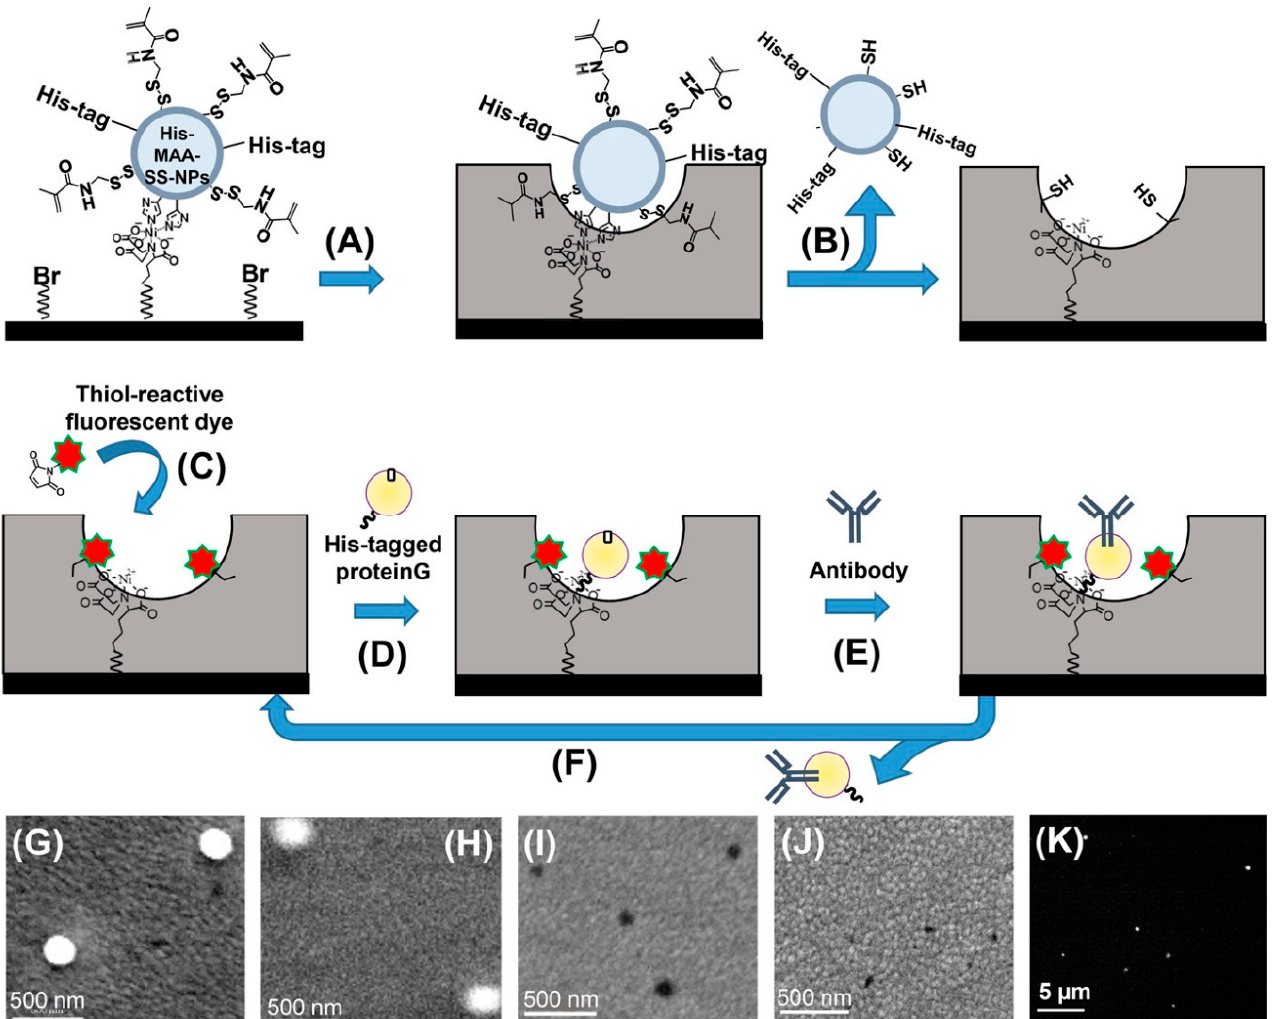
Figure 4. Molecular imprinting of detection cavities conjugated with specific antibodies for detecting intact small extracellular vesicles (sEVs). Nanoprocess of a biocompatible polymer matrix mold creation by immobilization of His-tags over silica nanoparticles ( A ) and their removal ( B ) to create sEV-binding cavities. Post-nanoprocessing via different chemical reactions, including the introduction of fluorescent dyes ( C ), His-tagged protein G ( D ), oriented protein G-based attachment of antibodies ( E ), and regeneration of sEV cavities ( F ). Scanning electron microscopic ( G – J ) and fluorescence ( K ) pictures of the different molding steps. Reused with permission from Ref. [37]. ©2020 American Chemical Society.